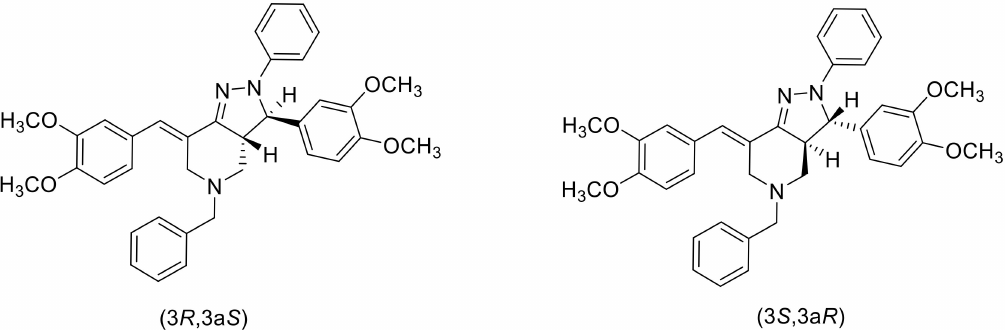
Figure 3. The two possibilities of configuration of compound 3